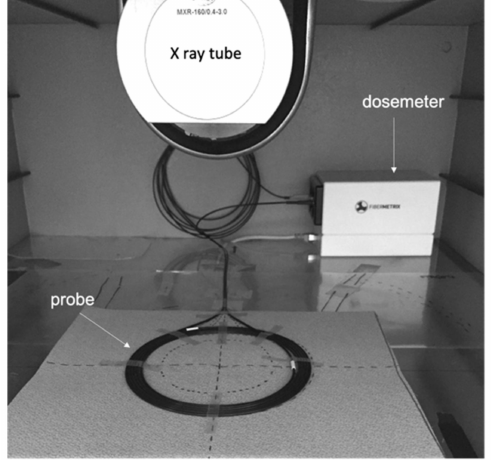
Figure 3. IVISCAN ® probe placement in the sealed irradiation facility.